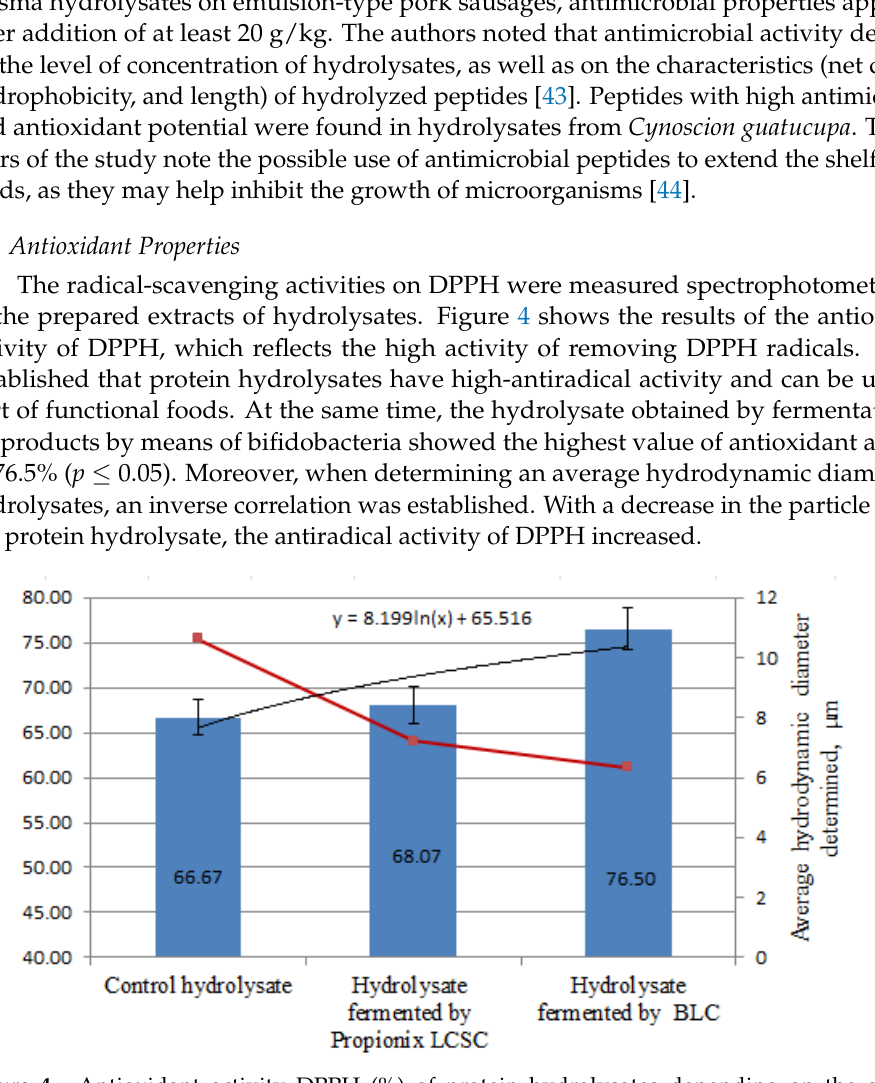
Figure 4. Antioxidant activity DPPH (%) of protein hydrolysates depending on the average particle